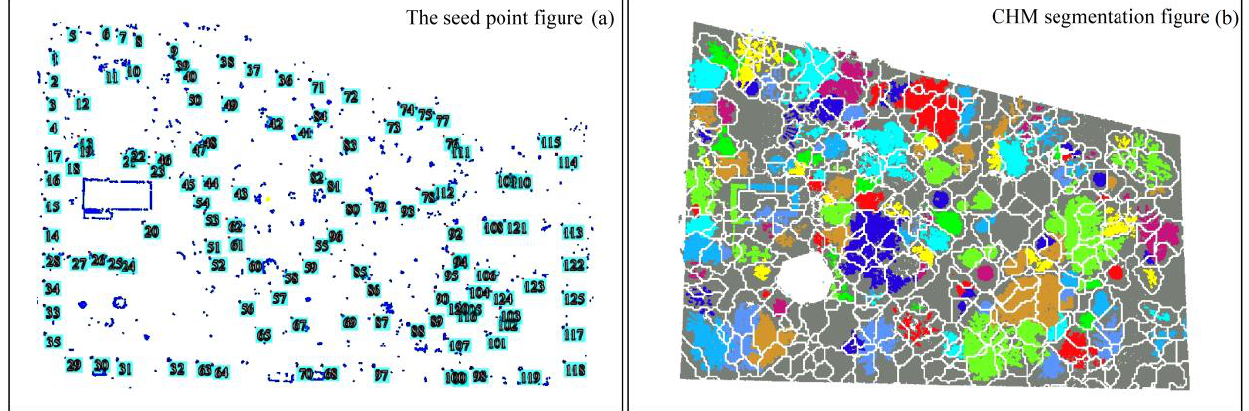
Figure 7. ( a ) Seed point and ( b ) CHM segmentations.